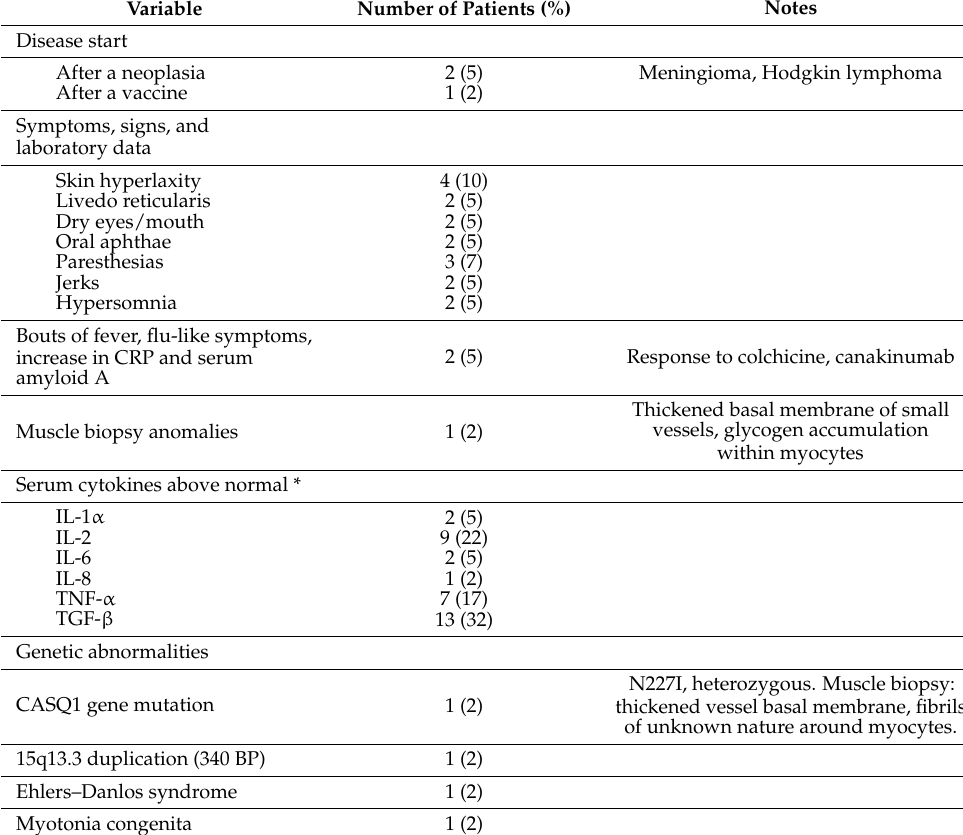
Table 2. Symptoms, laboratory data, and genetic abnormalities present in a minority of